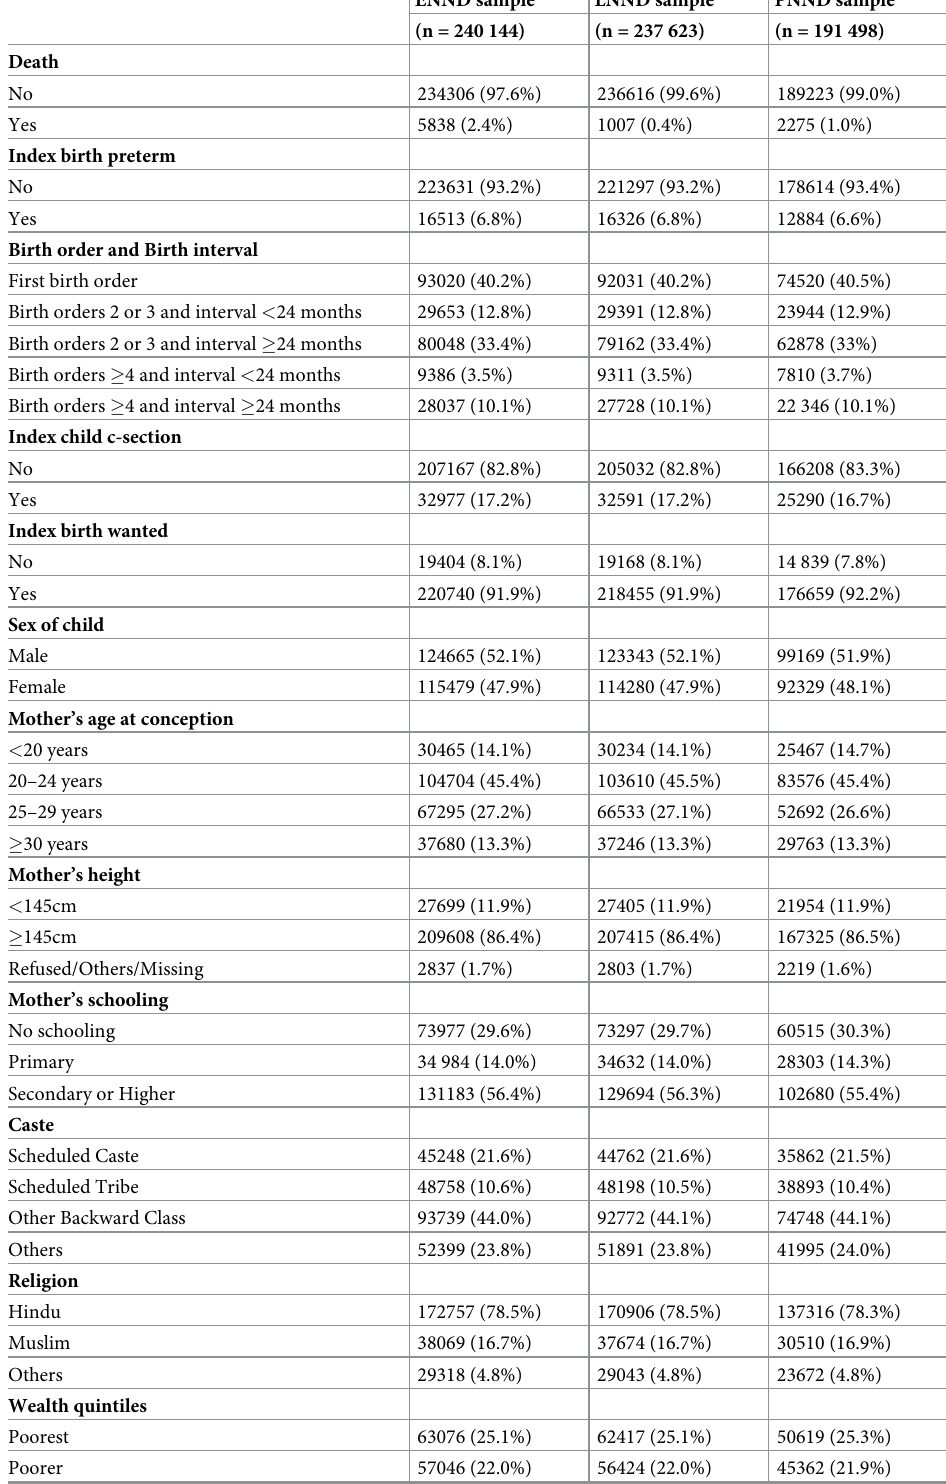
Table 1. Descriptive statistics of births included in the three samples, NFHS-4, India,